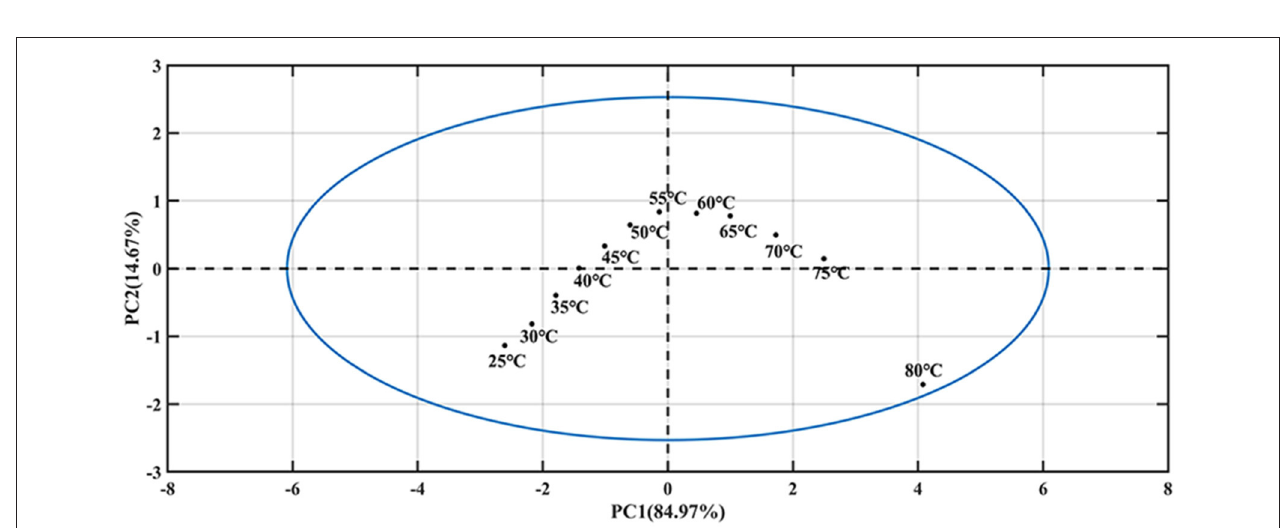
FIGURE 4 | The principal component score of Ara h1 aqueous solution at different